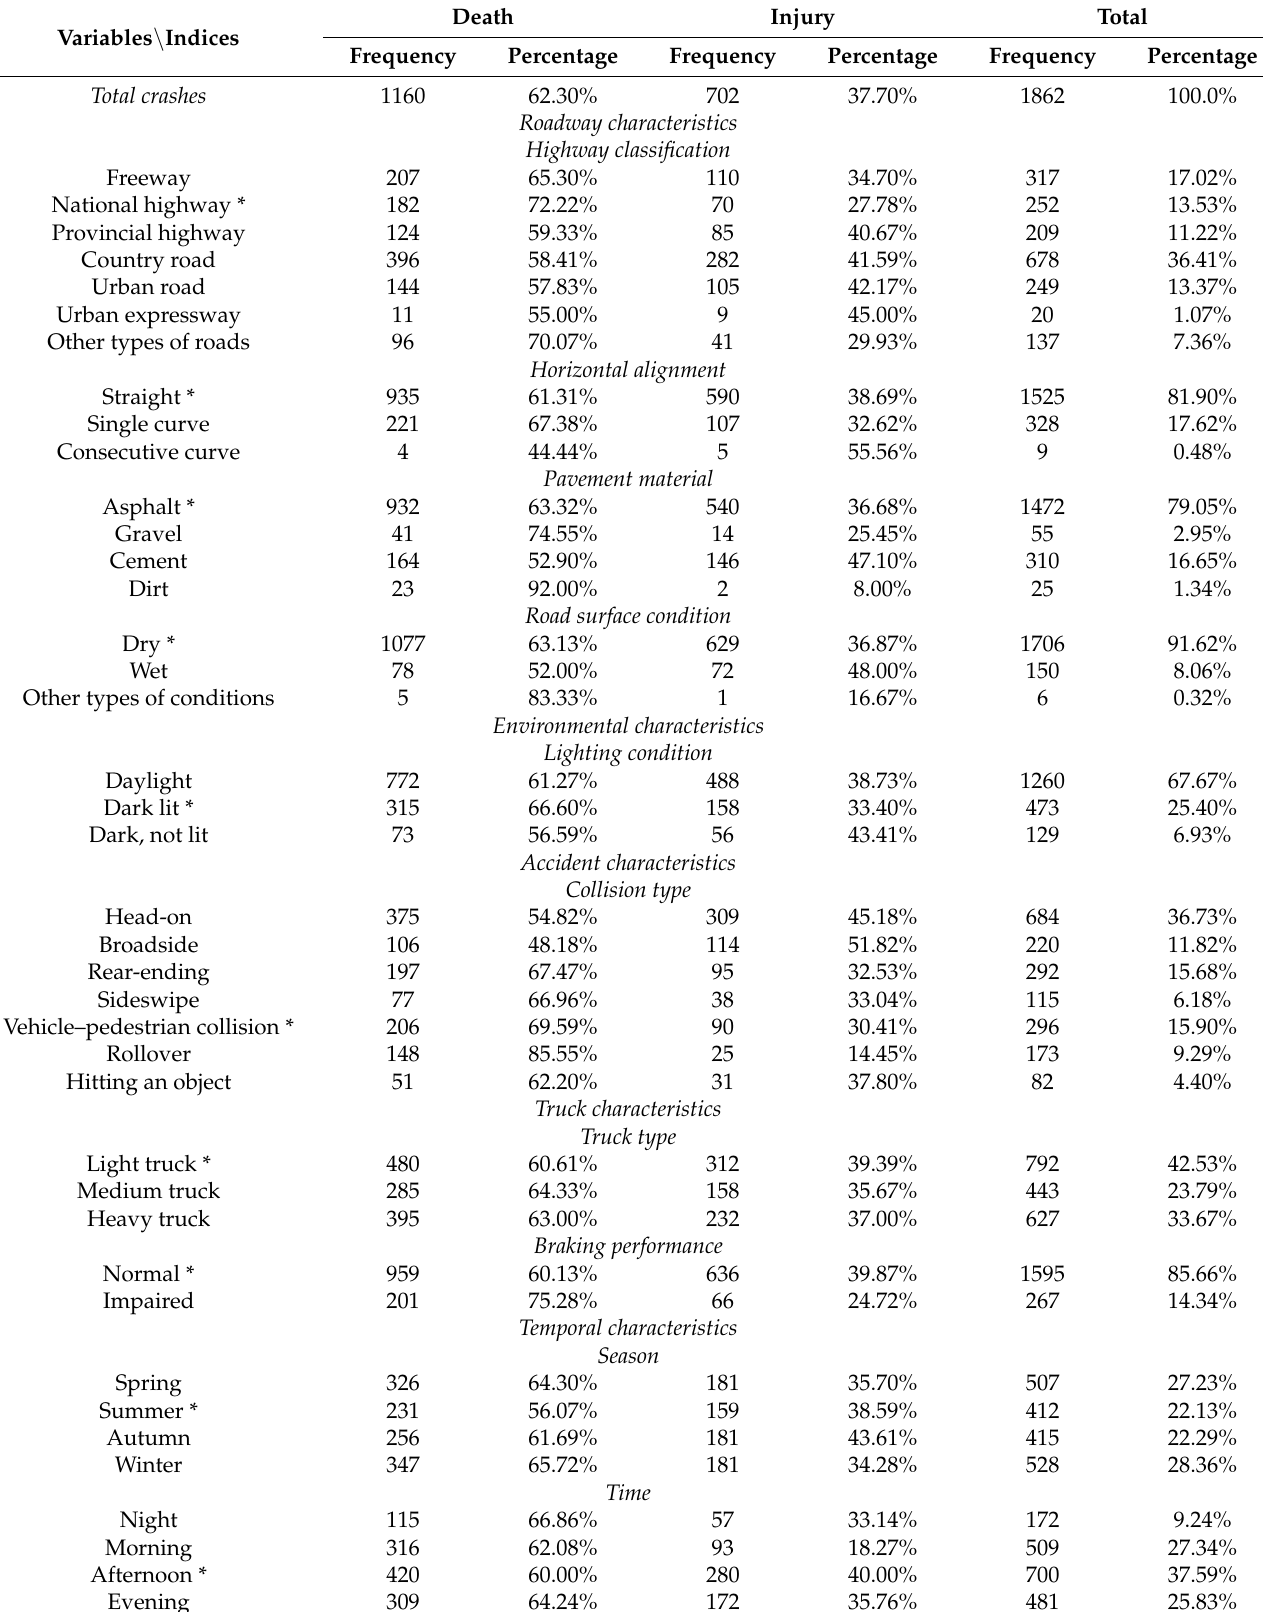
Table 1. Statistical characteristics of explanatory